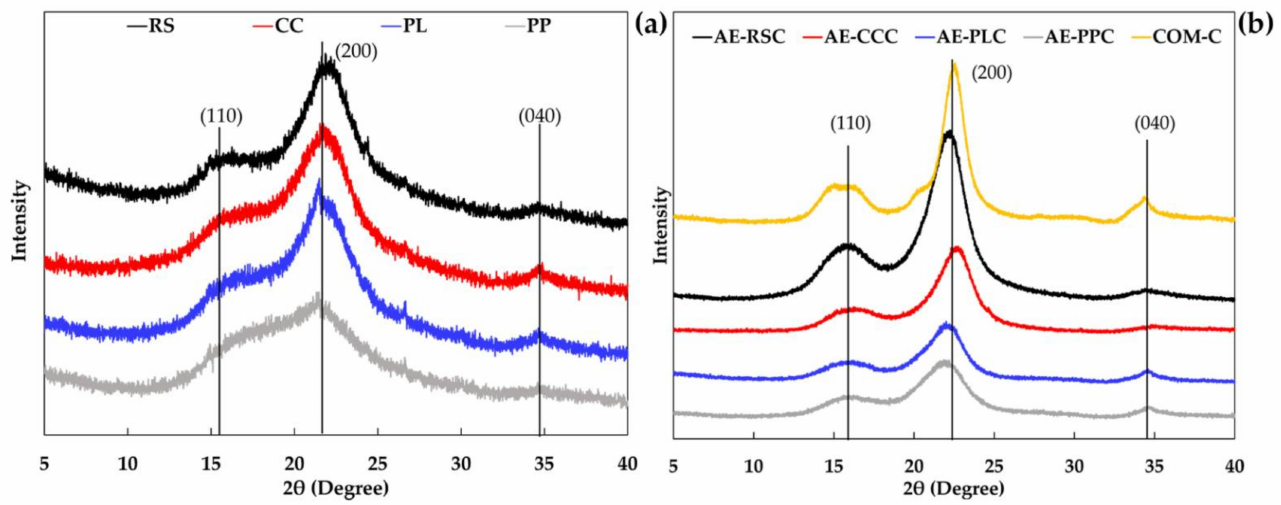
Figure 3. XRD spectra of cellulose samples without ( a ) and with ( b ) alkaline processing of agricultural waste materials and their comparison with the commercial cellulose. RS: rice straw; CC: corncob; PL: pineapple leaf; PP: pineapple peel; AE-RSC: alkaline extraction of rice straw cellulose; AE-CCC: alkaline extraction of corncob cellulose; AE-PLC: alkaline extraction of pineapple leaf cellulose; AE-PPC: alkaline extraction of pineapple peels cellulose; and COM-C: commercial